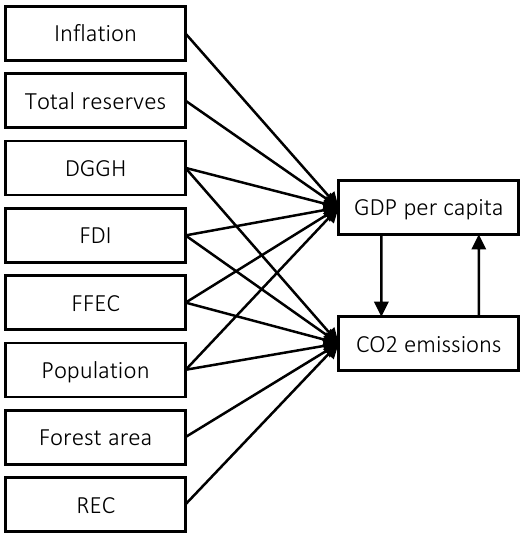
Figure 1. Simultaneous relationship model between through the Durbin-Watson Test. Multicollinearity arises when the independent variables are correlated with each other. Multicollinearity is the relationship between independent variables, which is a condition of a strong correlation between independent varia- bles or vice versa. The existence of multicollineari- ty can be determined through a correlation matrix or regression between independent variables in the equation model.